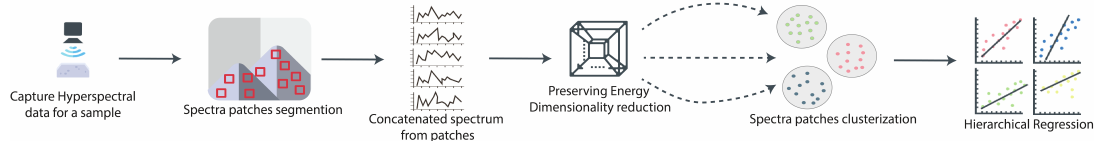
Figure 4. Hyperspectral image analysis by coherent clustering and hierarchical